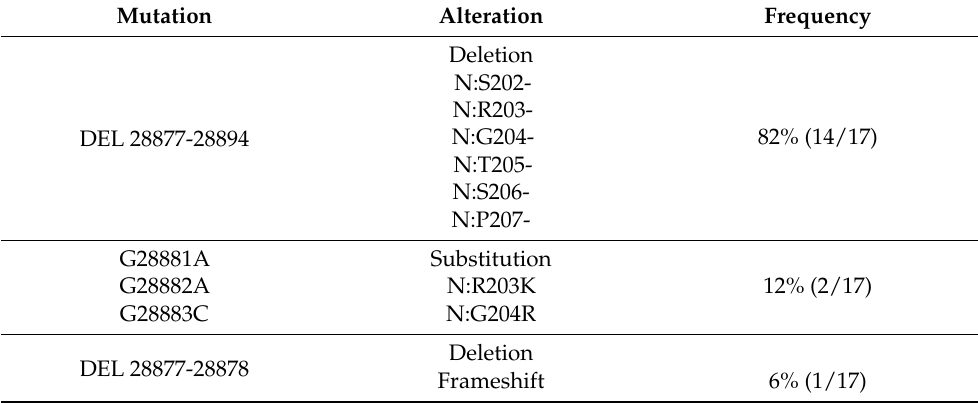
Table 1. Mutations in gene N detected by